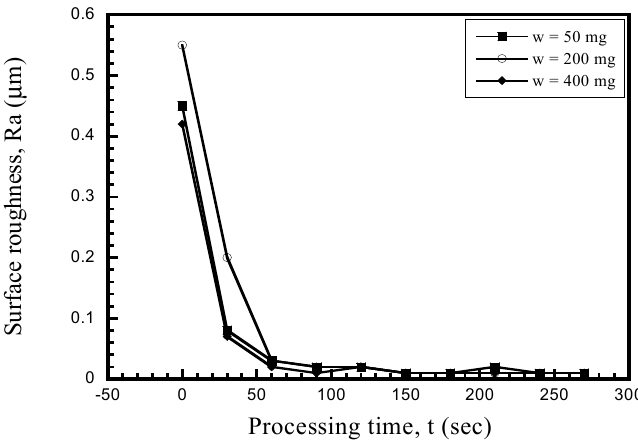
Figure 11. Variations of surface roughness ( R a) against processing time (diamond paste size: 1 µm, frequency of magnetic poles: 12 Hz).